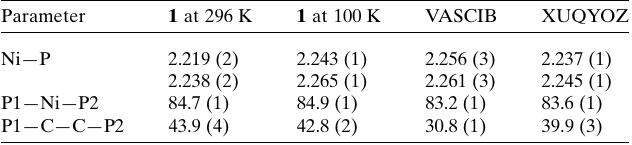
Table 1 Comparison of selected geometric parameters (A˚ , (cid:5) ) for 1 at 296 and 100 K, VASCIB and XUQYOZ.